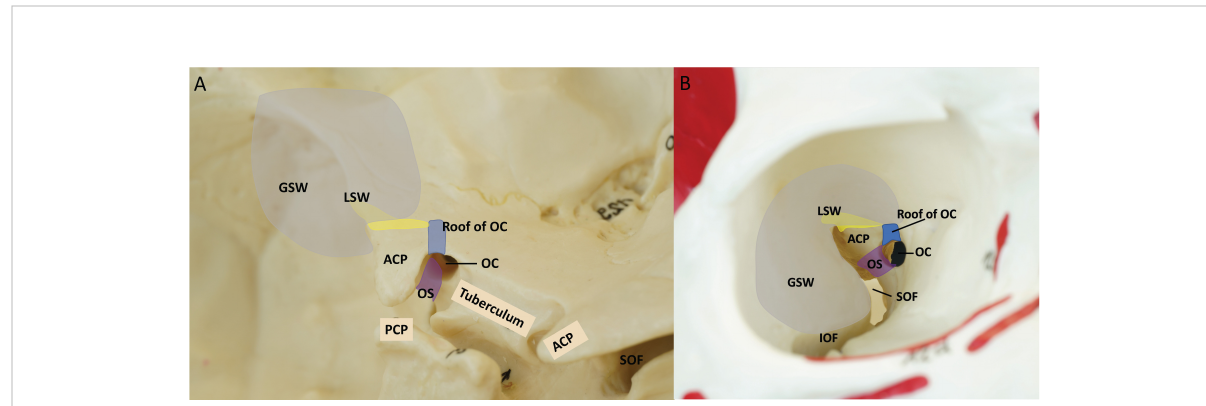
FIGURE 1 Three supporting roots of the ACP. Yellow = lesser wing of sphenoid bone (Lateral root), Blue = the roof of the optic canal (anterior root), Purple = optic strut (posterior root), Gray = craniotomy of endoscopic transorbital approach. (A) Left oblique view of the anterior bony skull base (B) Right intra orbital view. ACP, anterior clinoidal process; GSW, greater wing of sphenoid bone; IOF, inferior orbital fi ssure; LSW, lesser wing of sphenoid bone; OC, optic canal; OS, optic strut; PCP, posterior clinoidal process; SOF, superior orbital fi ssure.